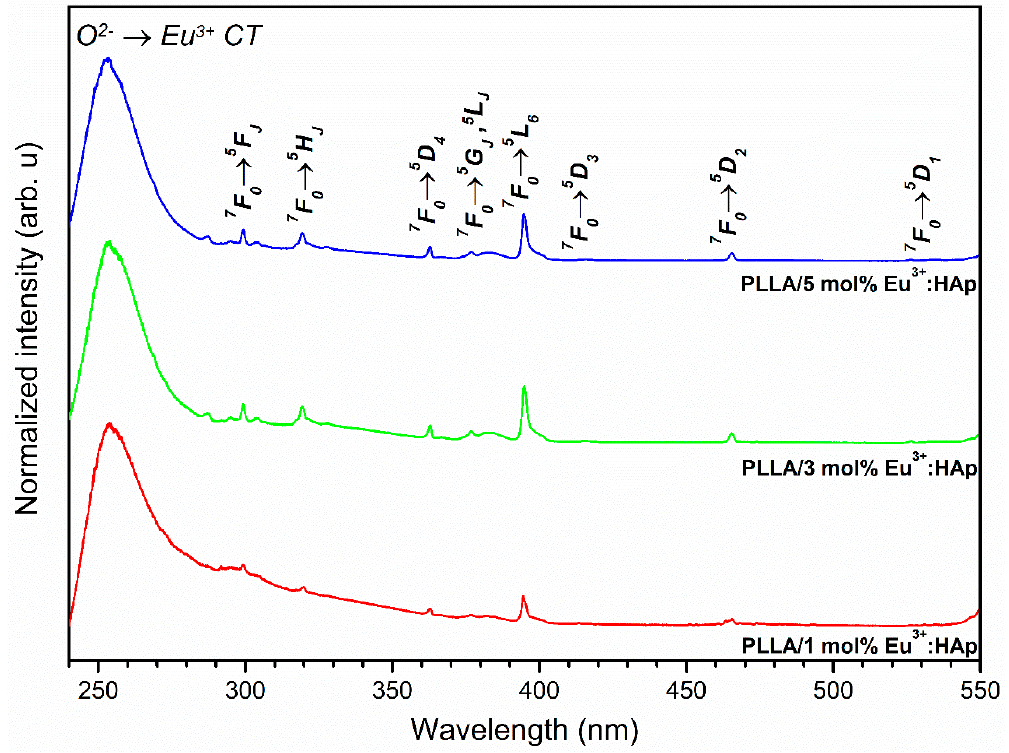
Figure 6. Excitation spectra of x mol% Eu 3 + :HAp nanoparticles (where x = 1–5) incorporated into PLLA composites.